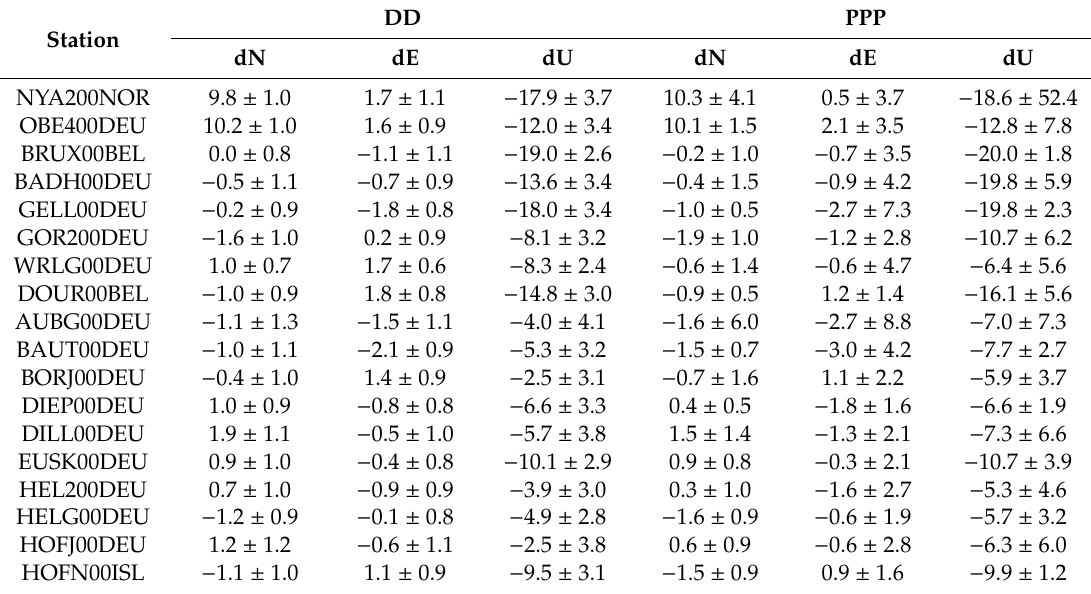
Table A2. Coordinate di ff erences between solution E1 and E3 (E3 minus E1) and their standard deviations. All values in